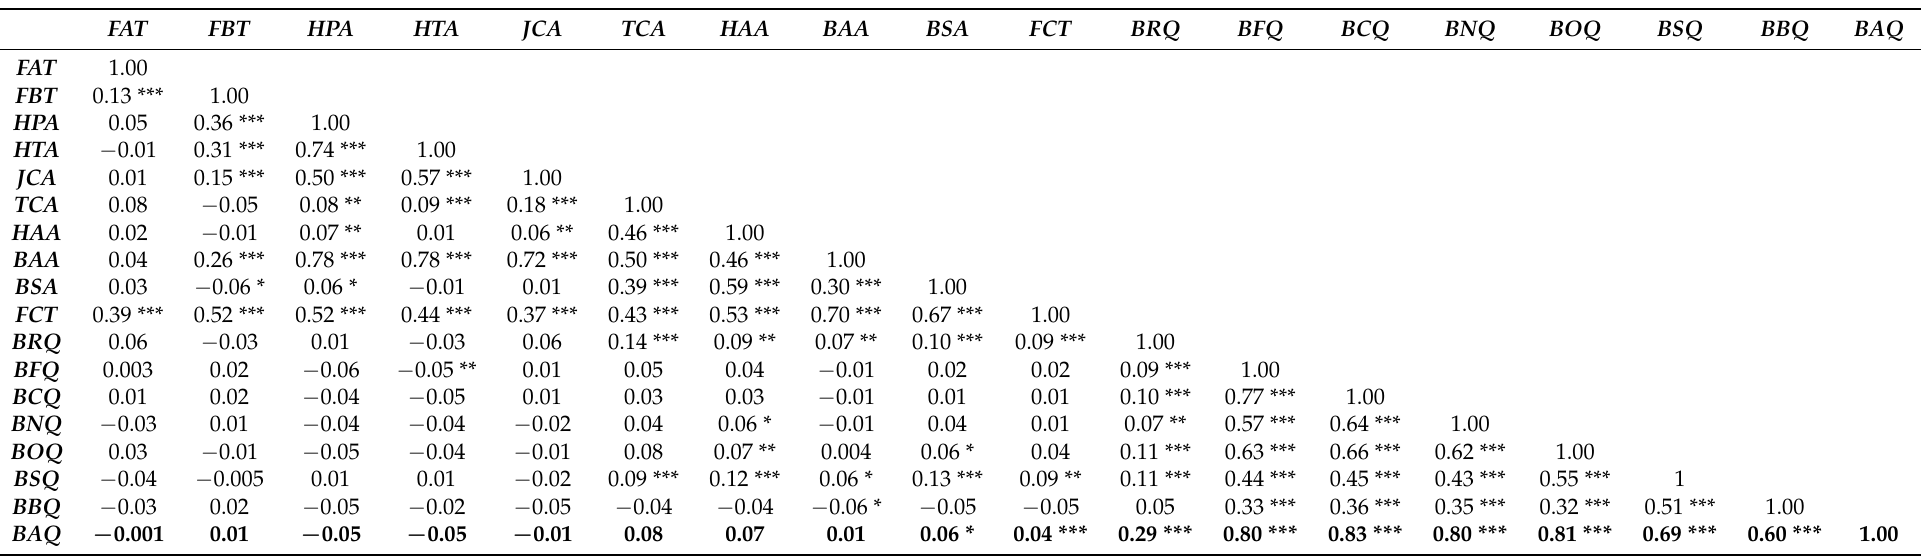
Table 7. The correlation matrix of hidden research variables for listed